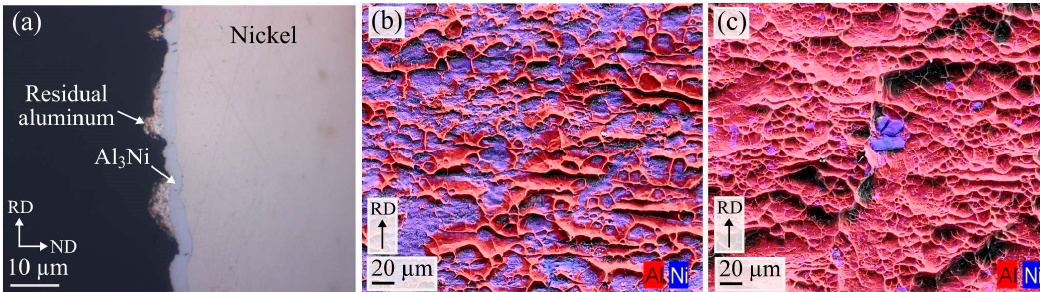
Figure 12. Images showing the fracture mechanism observed in the composites heat treated at 450 °C where only a layer of Al 3 Ni was present along the interface. ( a ) shows a low magnification optical microscopy image of the cross-section of the fracture surface, where residual aluminum is clearly observed on the Al 3 Ni layer and no sign of fracturing can be seen along the Al 3 Ni-nickel interface. ( b ) shows an SEM image combined with EDS color map of the Al 3 Ni fracture surface and ( c ) shows the corresponding aluminum fracture surface. The detected aluminum is colored red and nickel blue.